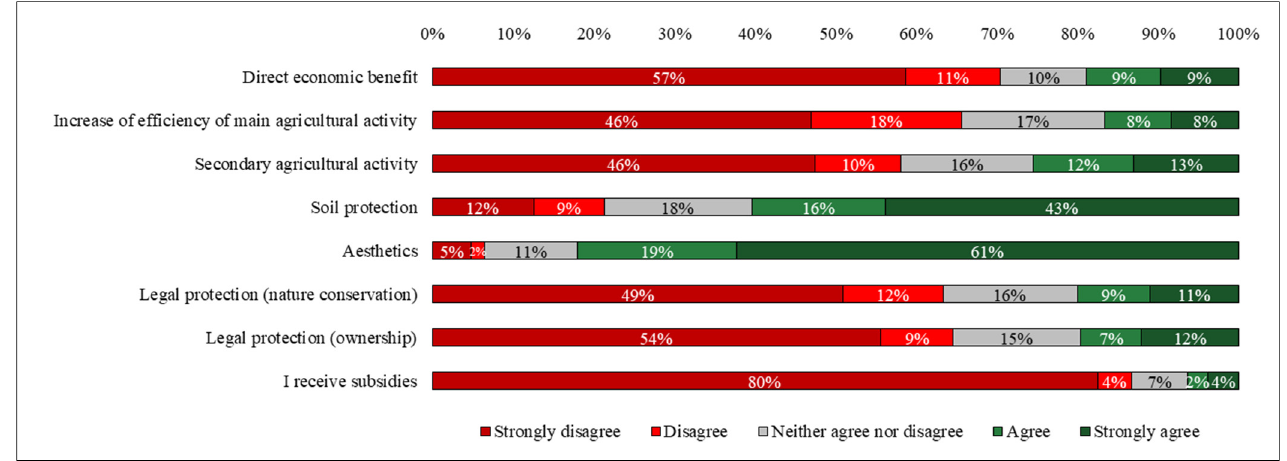
Figure 2. Reasons why farmers retain the trees on their agricultural land. Numbers indicate the percentage of farmers from the total number of farmers (n = 448).